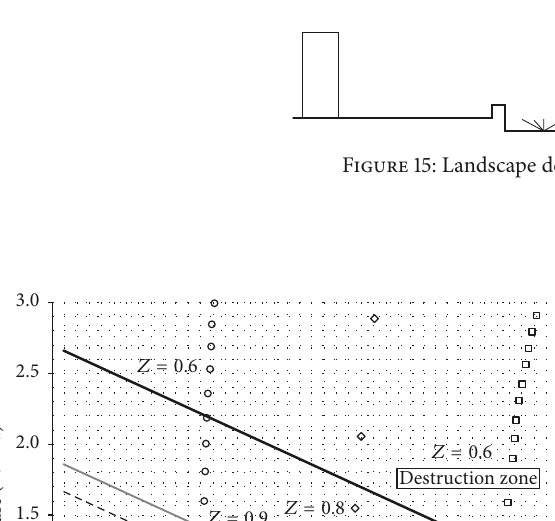
guidelines were suggested for retrofitting of masonry with